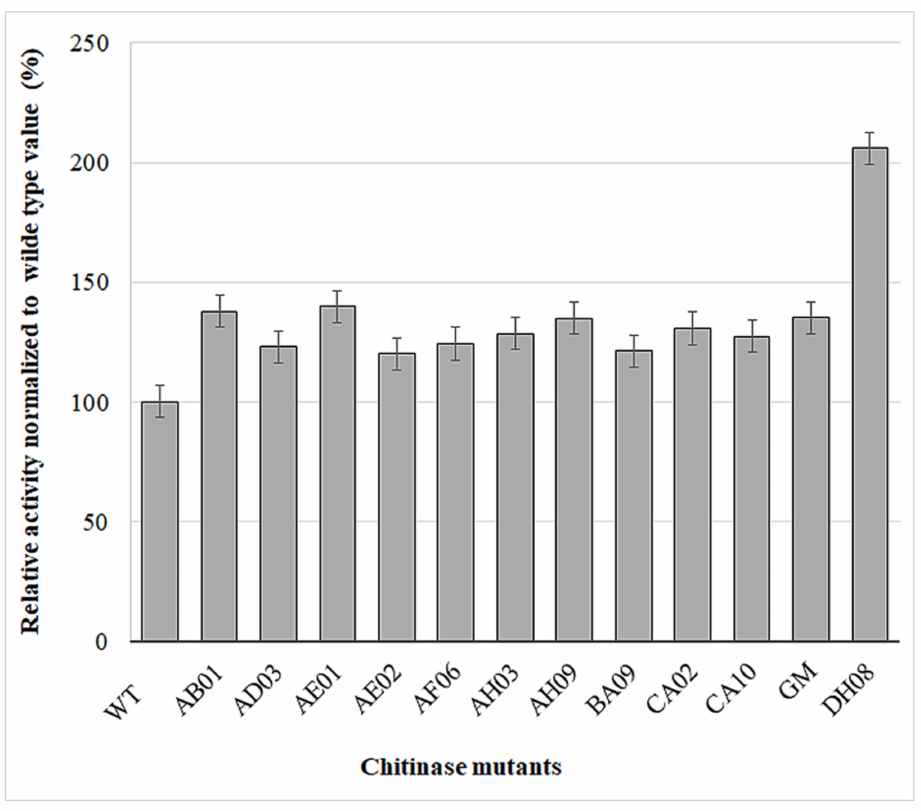
Figure 5. Relative activity of 12 ChiA mutants identified by FACS-based screening, normalized to wild-type ChiA. Data are means ± standard errors representing n = 3